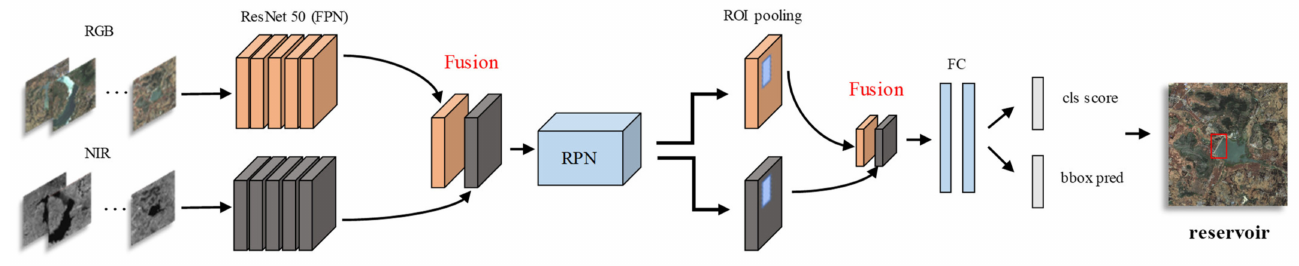
Figure 11. The architecture of NIR RCNN that designed for fine-grained identify and localize reservoirs and dams, with a dual-stream structure and two fusion